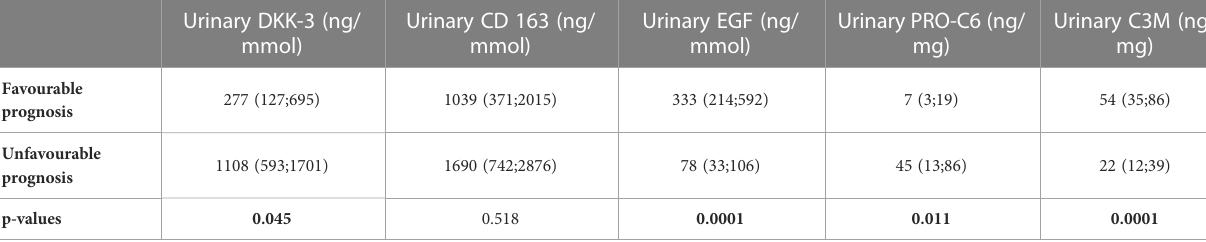
TABLE 8 Biomarker concentrations in urine at baseline in patients with favourable prognosis (serum creatinine at follow-up<156 µmol/l) and unfavourable prognosis (serum creatinine at follow-up>156 µmol/l, HD and